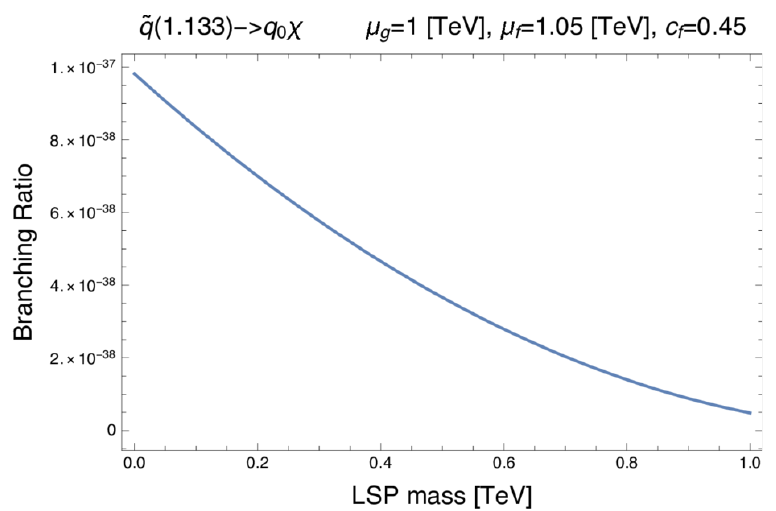
Figure 9. Branching ratio of KK squark decaying to a SM quark and LSP as a function of LSP mass.